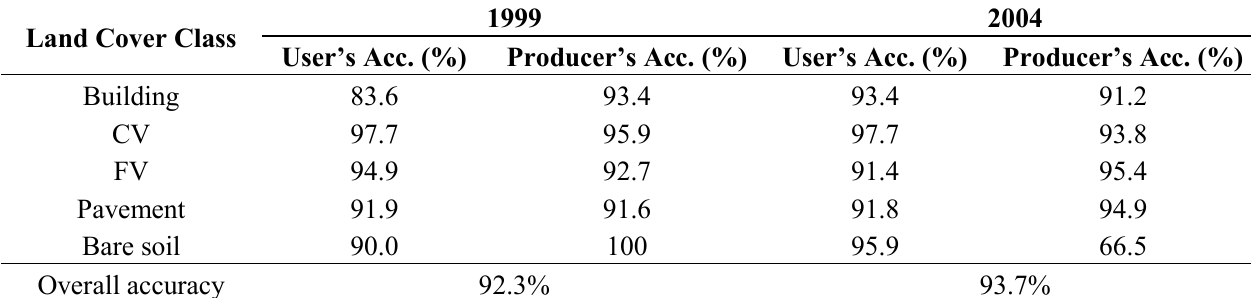
Table 3. Summary of the classification accuracies of land cover features for 1999 and 2004, using an object-based classification